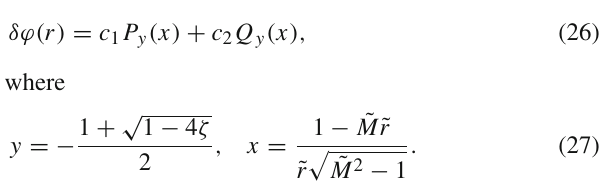
Fig. 2 The left two panels show the asymptotic value δϕ | r →∞ of the perturbation scalar field as a function of the parameter ζ = 2 ˜ Q e ˜ Q m λ 2 for different reduced mass ˜ M = M / Q tot . The top right panel shows the parameters (ζ, ˜ M ) ofthefirstsixbifurcations(theperturbationsolutions